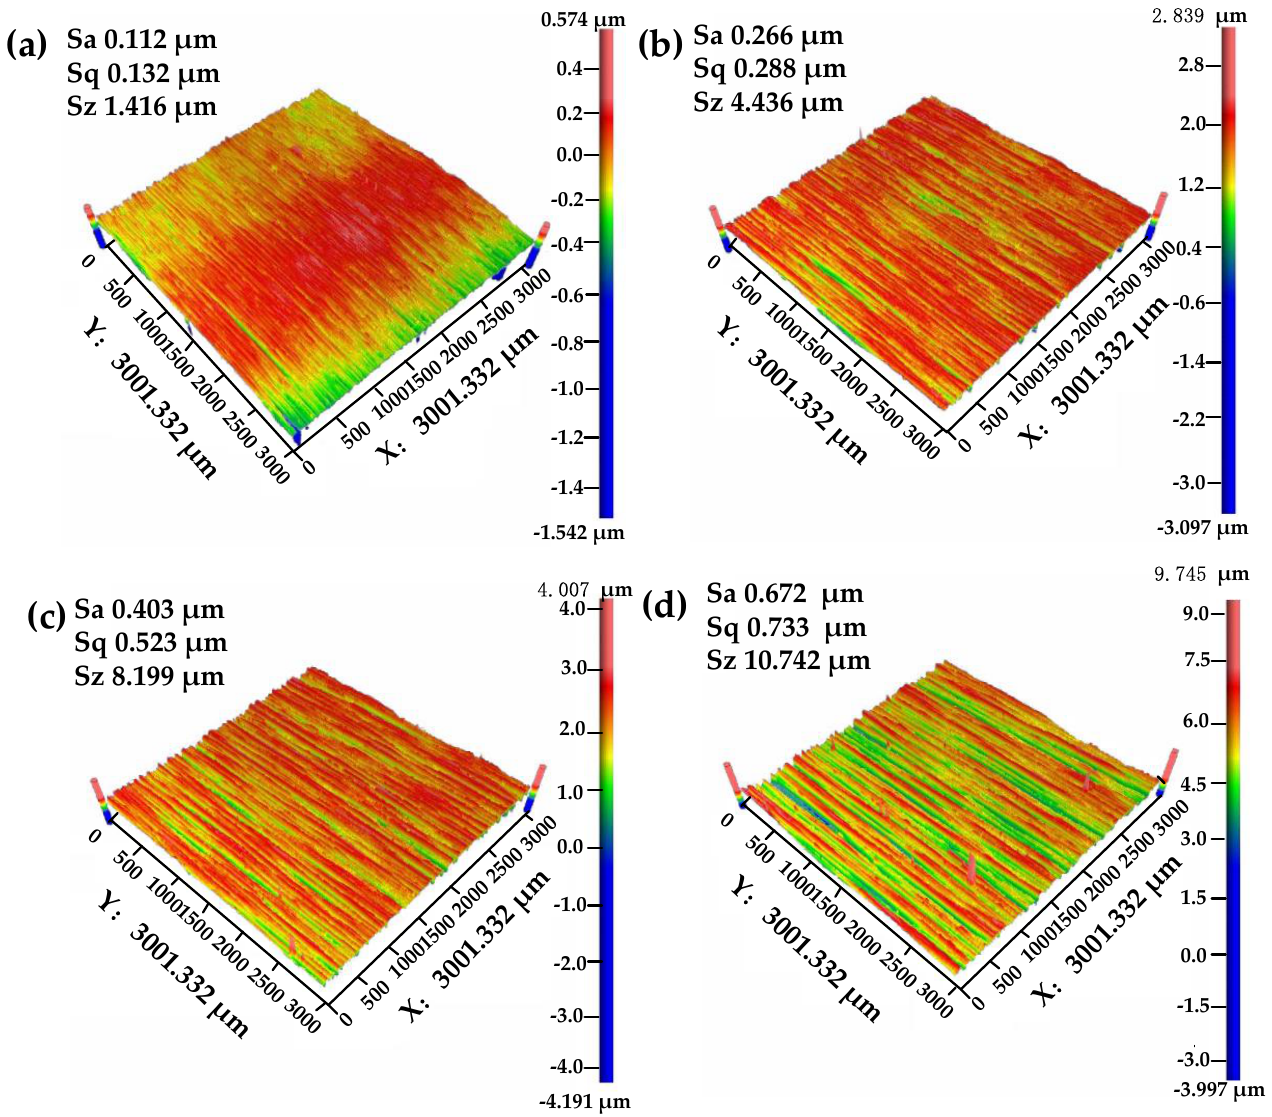
Figure 1. Measured grinding surfaces: ( a ) Surface 1; ( b ) Surface 2; ( c ) Surface 3; ( d ) Surface 4. The power spectral density analysis is performed on the measured grinding surfaces. The calculation flow of 2D power spectral density can be found in Figure S1. Figure 2 shows the 2D power spectral density of the measured surfaces.